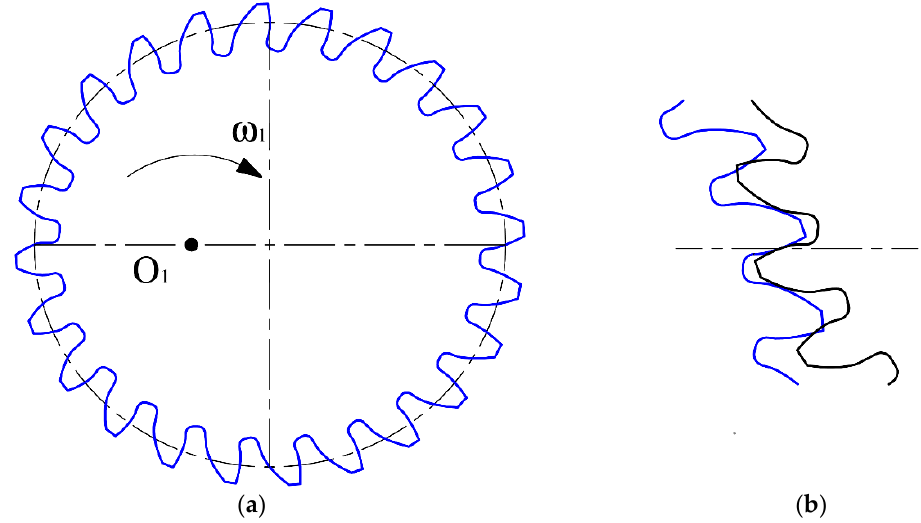
Figure 8. ( a ) Resulting shape of the gear; ( b ) the teeth interfere—the conditions of correct meshing are not